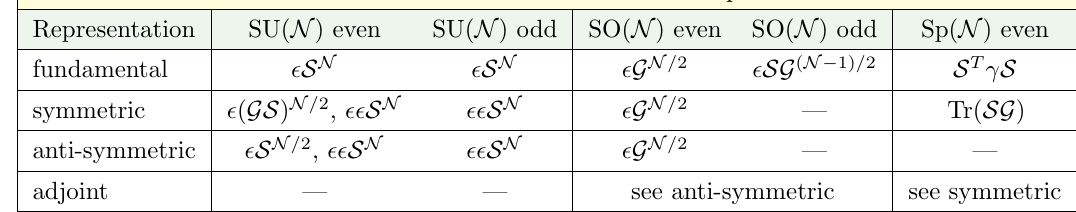
Table 2 . Stable DM candidates in the con(cid:12)ned phase. A | denotes no accidental DM candidate, either because the action contains S 3 cubics (SU and Sp theories) or because di-baryons are unstable (SO